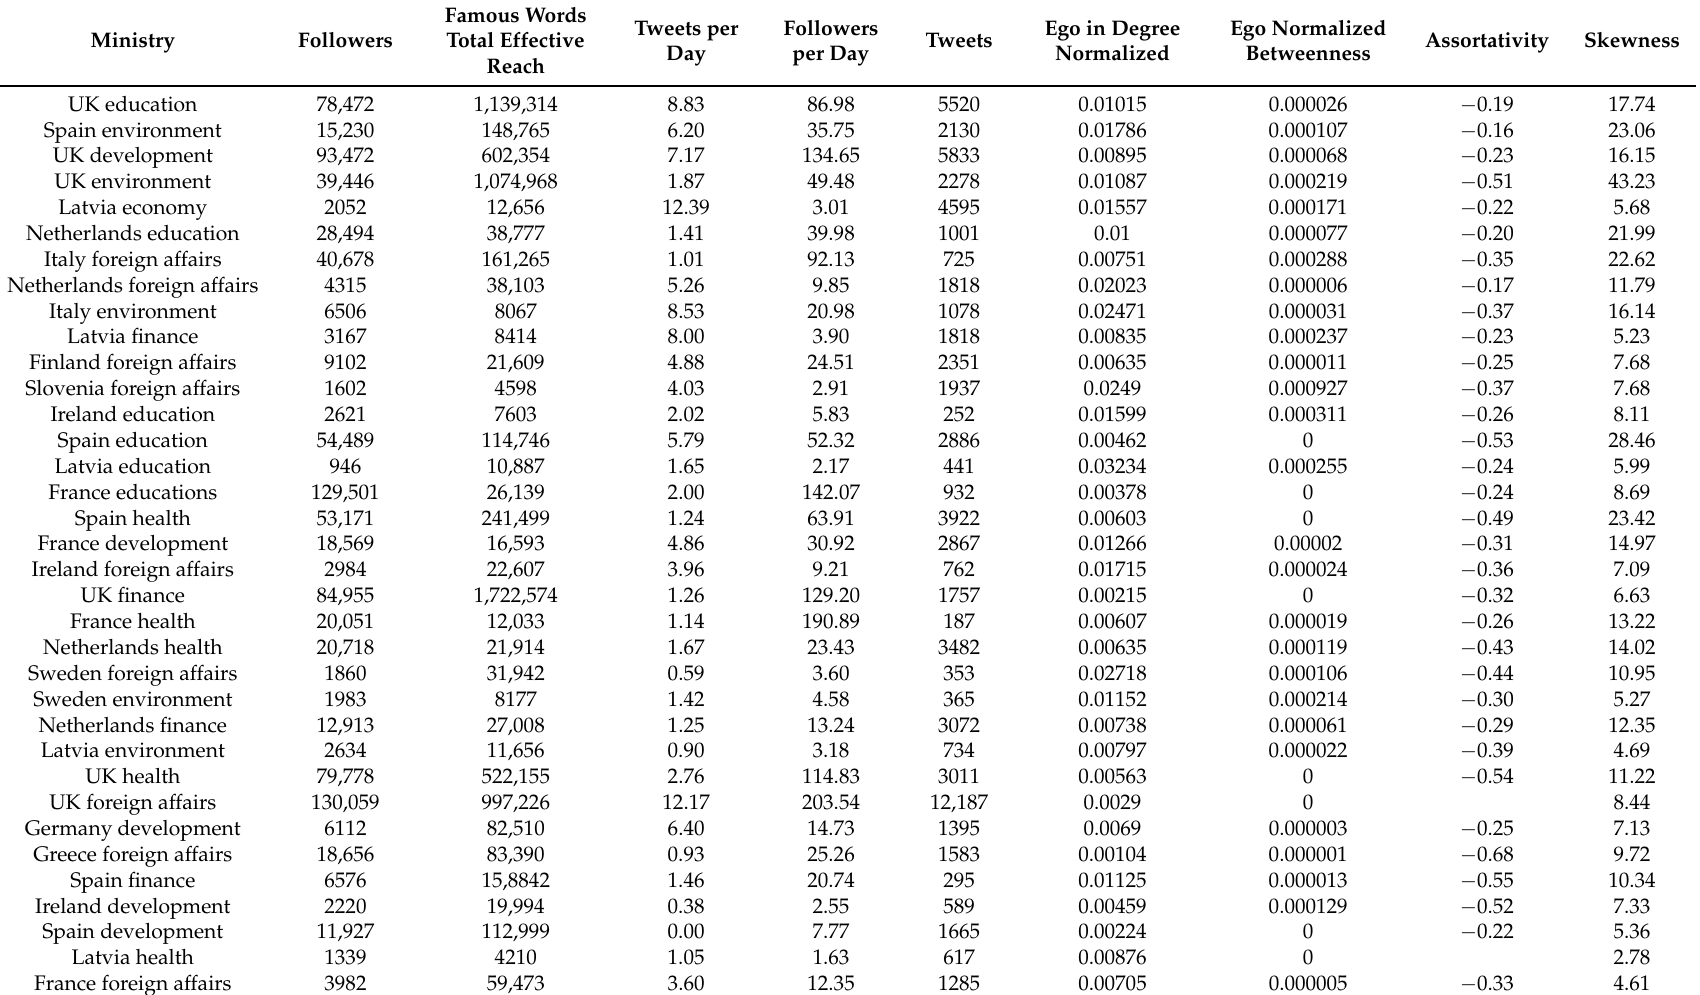
Table 5. Values of the original indexes of the 56 EU ministries’ Twitter